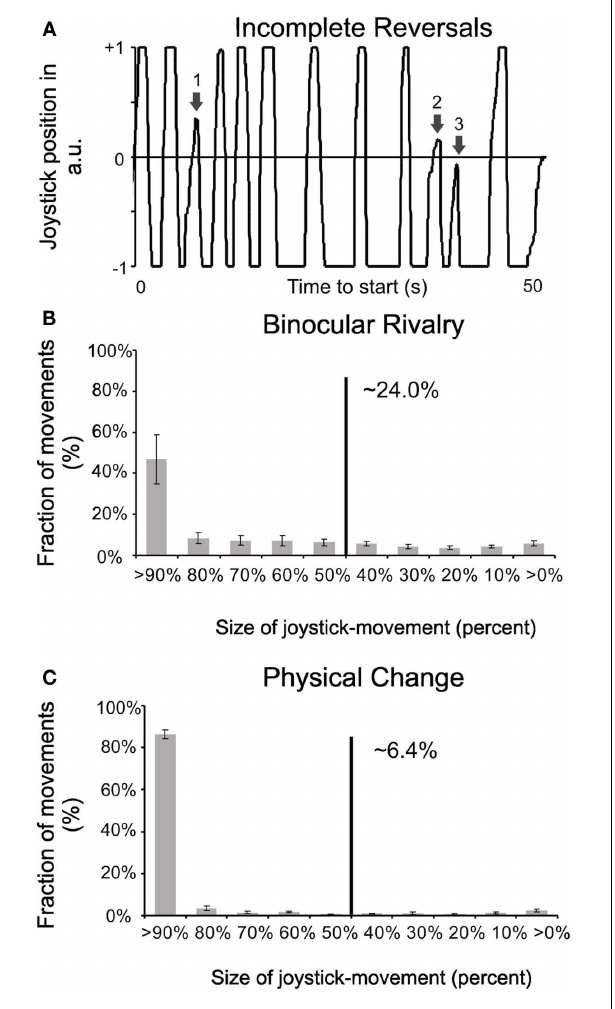
FIGURE 3 | Complete versus incomplete reversals. (A) Example for interrupted joystick movements, for an arbitrary 50s period ( x -axis). Joystick position “1” signals a complete percept of a dark grating and position “ − 1” that of a bright grating ( y -axis). Movement “1” is considered as a sufficient transition ( > 60%), “2” is still considered as a sufficient reversal ( > 50%) but not included in pupil analysis while “3” is considered as an incomplete reversal ( < 50%), i.e., it does not qualify as a transition. (B) Percentages of complete versus incomplete joystick movements for changes during rivalry. Movements of less than half amplitude are considered as “incomplete” here since they indicate that percepts did not switch sufficiently to the competing stimulus or else the dominance of the competing stimulus was too short lived. (C) Percentages of complete versus incomplete joystick movements for physical stimulus changes. Note that the Poisson distribution determining physical changes contained dominance times down to 20ms, leading observers to change joystick-direction before the reached the